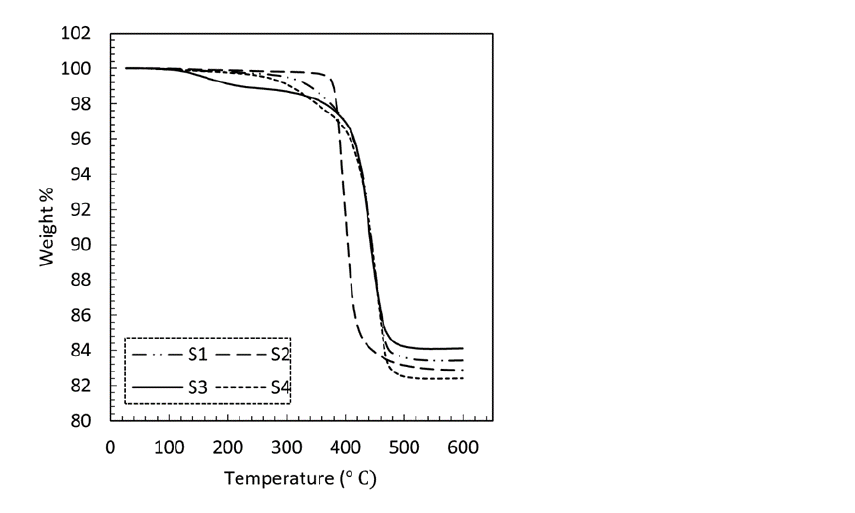
Figure 10. TGA data of magnetic composites as listed in Table 1. Table 2. Residue weight percentage at different temperatures for composites as listed in Table 1.